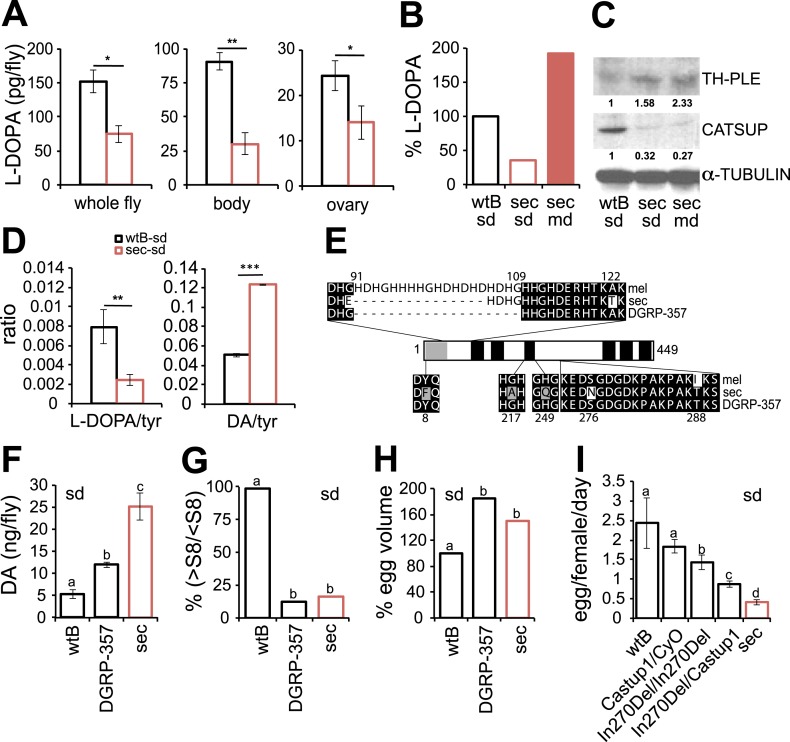
Dopamine metabolism is impaired in D. sechellia.(A) L-3,4-dihydroxyphenylalanine quantification (l-DOPA pg/fly) (N = 3) in whole fly, bodies and ovaries of female D. melanogaster wild-type Berlin (wtB) and D. sechellia (14021–0248.25, sec) fed a standard diet (sd). *p < 0.05 and **p < 0.002 using Student's t test. (B) Relative L-3,4-dihydroxyphenylalanine (% pg l-DOPA per mg body, % l-DOPA) (N = 3) in female D. melanogaster wild-type Berlin (wtB) and D. sechellia (14021–0248.25, sec) fed a standard diet (sd) or morinda diet (md). p = 0.0062 and p = 0.018 using Student's t test D. melanogaster vs D. sechellia fed, respectively, a standard diet or morinda diet. (C) Western blots of total protein whole-fly extracts for TH-PLE, CATSUP, and α-TUBULIN as a loading control, in D. melanogaster wild-type Berlin (wtB) and D. sechellia (14021–0248.25, sec) fed a standard diet (sd) or morinda diet (md). The numbers under TH-PLE and CATSUP protein lanes indicate the relative protein levels (normalised to α-TUBULIN). (D) Ratios of L-3,4-dihydroxyphenylalanine (l-DOPA/tyr) (N = 3) and dopamine (DA/tyr) (N = 3) to tyrosine substrate in female D. melanogaster wild-type Berlin (wtB) and D. sechellia (14021–0248.25, sec) fed a standard diet (sd). **p < 0.007 and ***p < 0.000007 using Student's t test. (E) Drosophila CATSUP protein structure scheme showing a signal peptide (grey box) and six trans-membrane domains (black boxes). Deletions (dash) and exchanges (grey or white) of amino acids in D. sechellia (14021–0248.25, sec) compared to in D. melanogaster wild-type Berlin (wtB) and in D. melanogaster DGRP-357 (DGRP-357) CATSUP are indicated. (F–H) Dopamine (DA ng/fly) (N = 3) (F), relative rate of vitellogenesis (% >S8/<S8) (N > 10) (G), and egg-volume (% mm3(10−3)) (n > 10) (H) in D. sechellia (14021–0248.25, sec), D. melanogaster wild-type Berlin (wtB) and D. melanogaster DGRP-357 (DGRP-357) fed a standard diet (sd). (I) Egg production (egg/female/day) (N > 3) in D. melanogaster wild-type Berlin (wtB), heterozygote flies (Catsup1/CyO), D. melanogaster DGRP-357 (CatsupIn270Del/CatsupIn270Del), trans heterozygote flies (CatsupIn270Del/Catsup1) and D. sechellia (14021–0248.25, sec), fed a standard diet (sd). Different letters denote significant differences (p < 0.05) using ANOVA followed by Tukey's test (F–I). Error bars represent s.e.m.